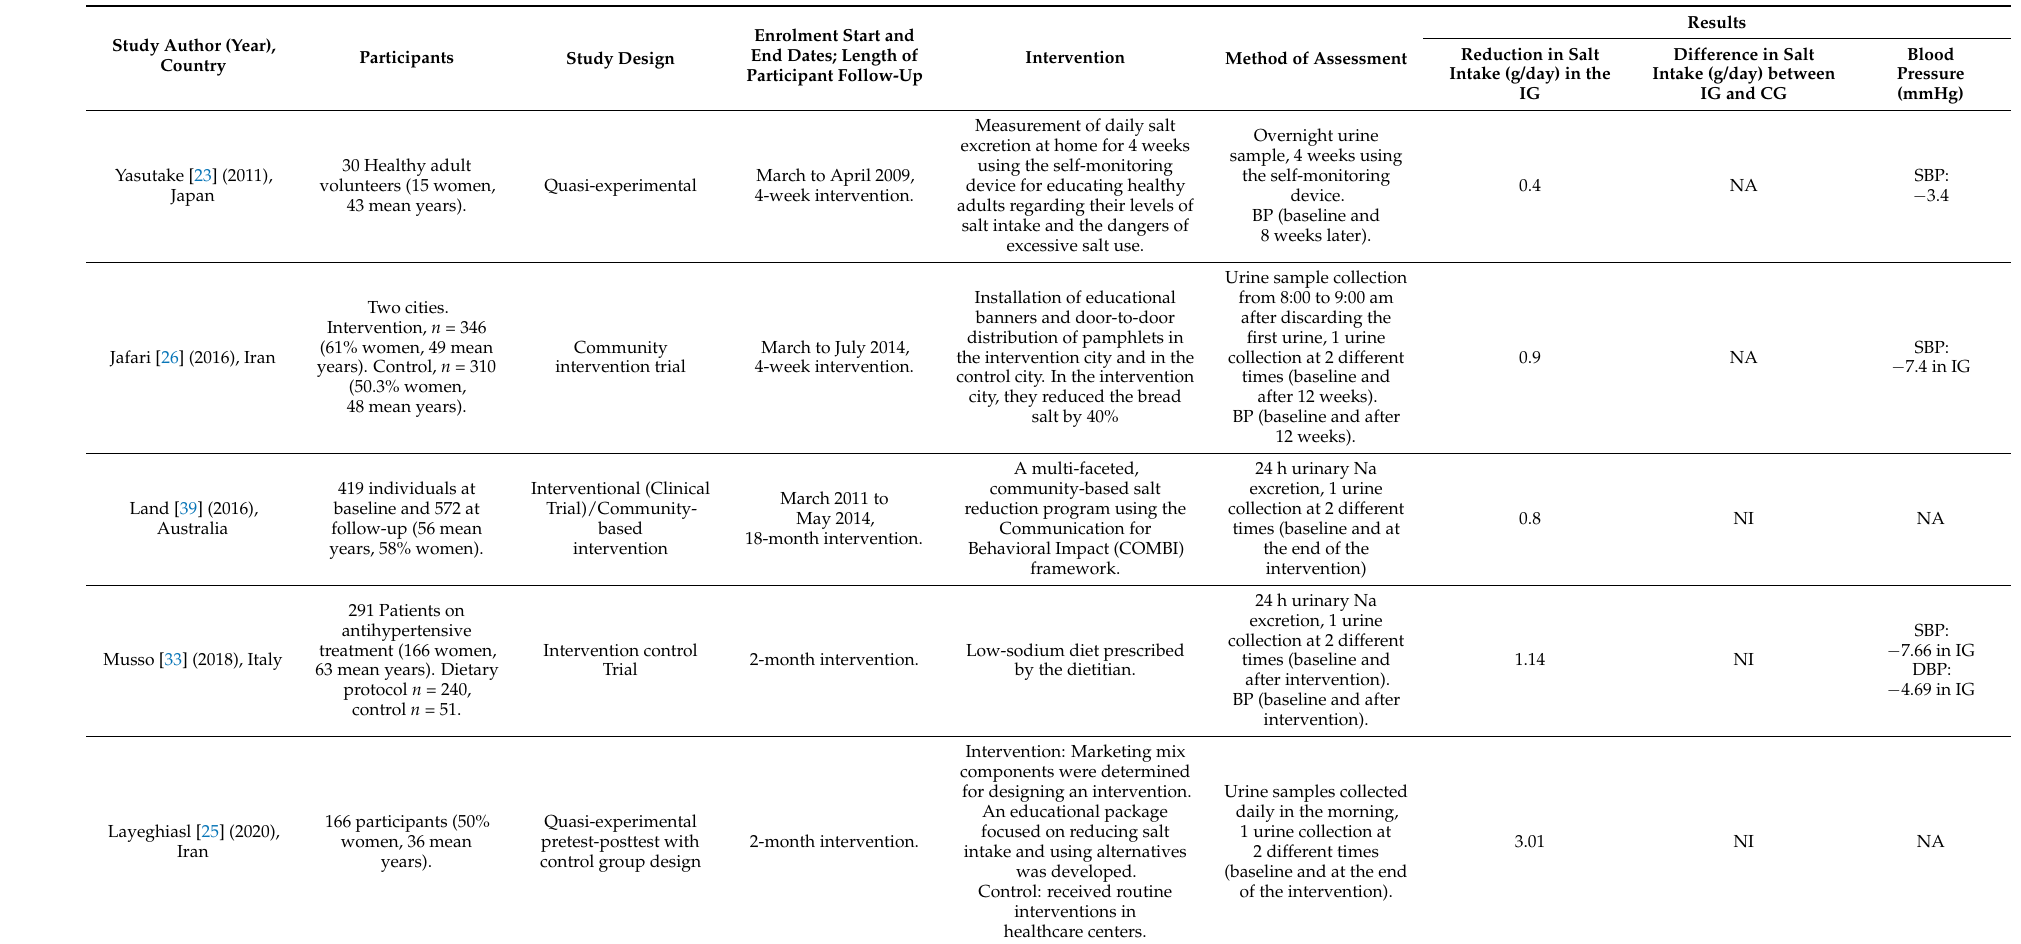
Table 2. Overview of characteristics of the included nonrandomized